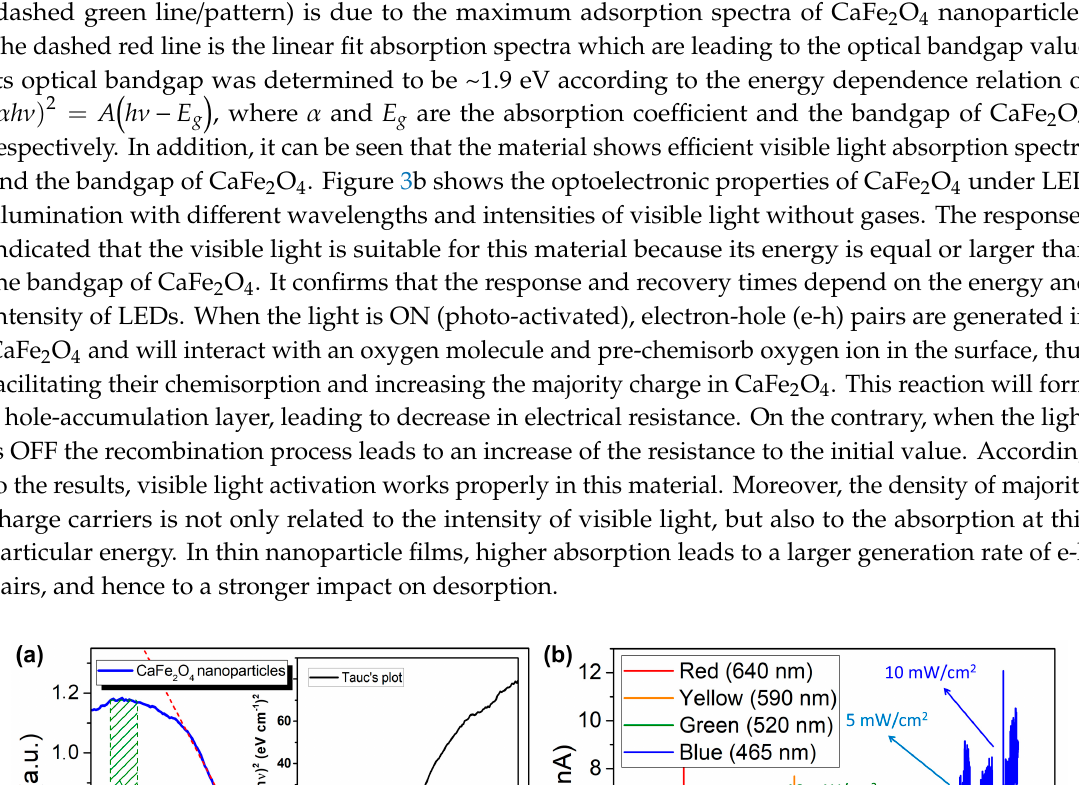
(dashed green line / pattern) is due to the maximum adsorption spectra of CaFe 2 O 4 nanoparticles. The dashed red line is the linear fit absorption spectra which are leading to the optical bandgap value.